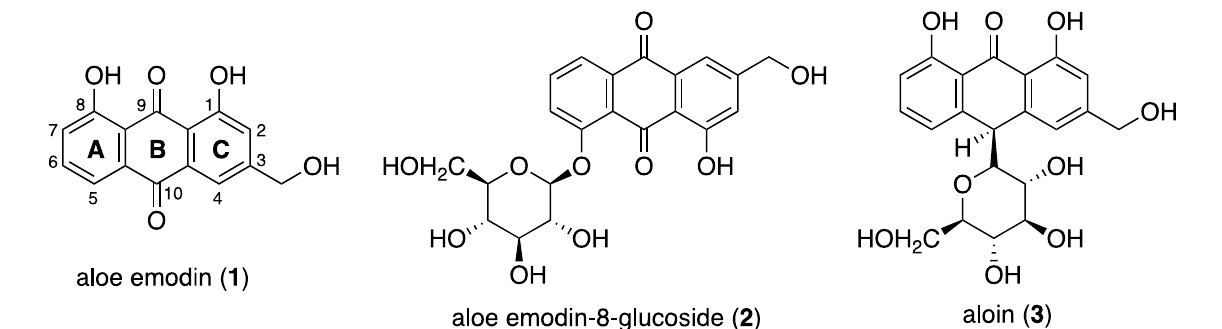
Figure 1. Structures of the main A . vera anthraquinones aloe emodin ( 1 ), aloe emodin ‐ 8 ‐ glucoside ( 2 ) and aloin ( 3 ).